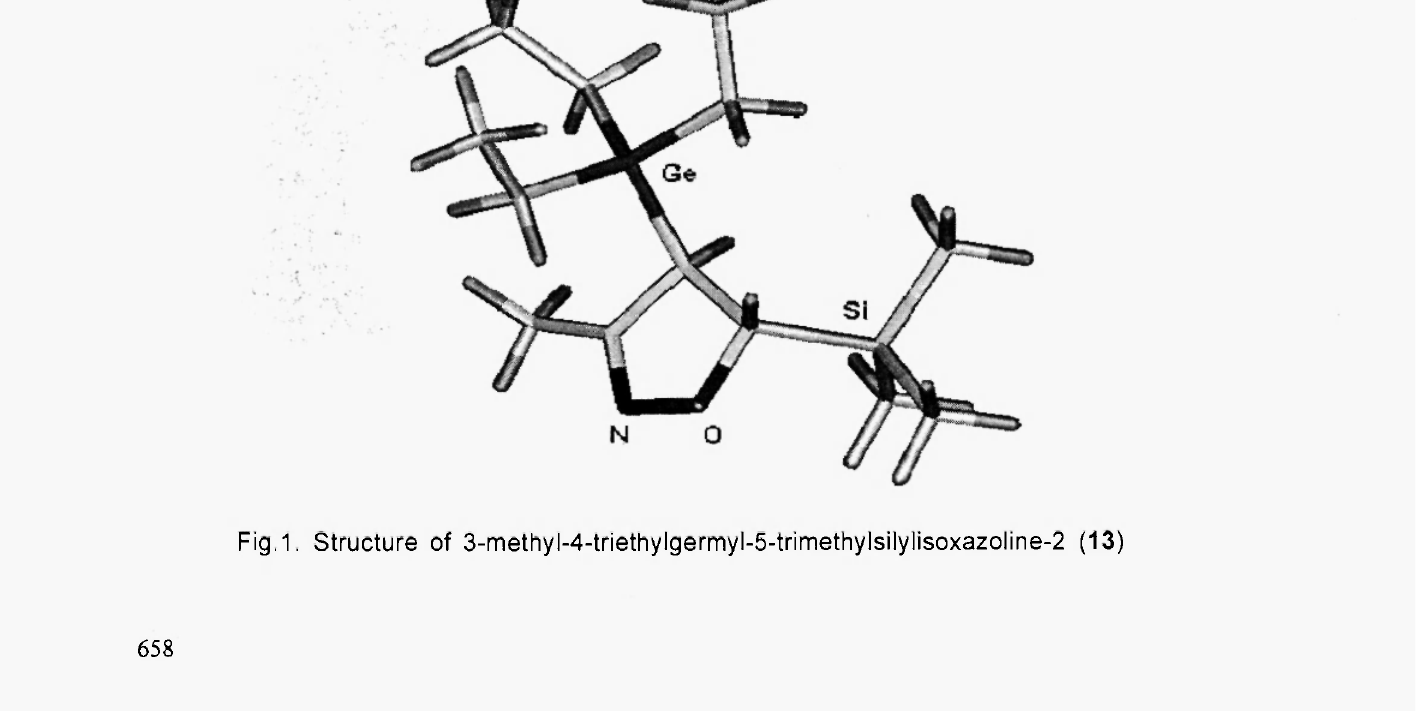
Fig. 1. Structure of